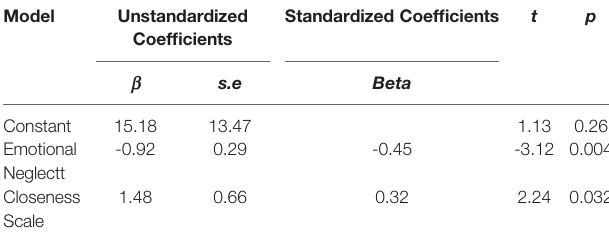
TABLE 4 | Predictors of social cognition in patients with alcohol use